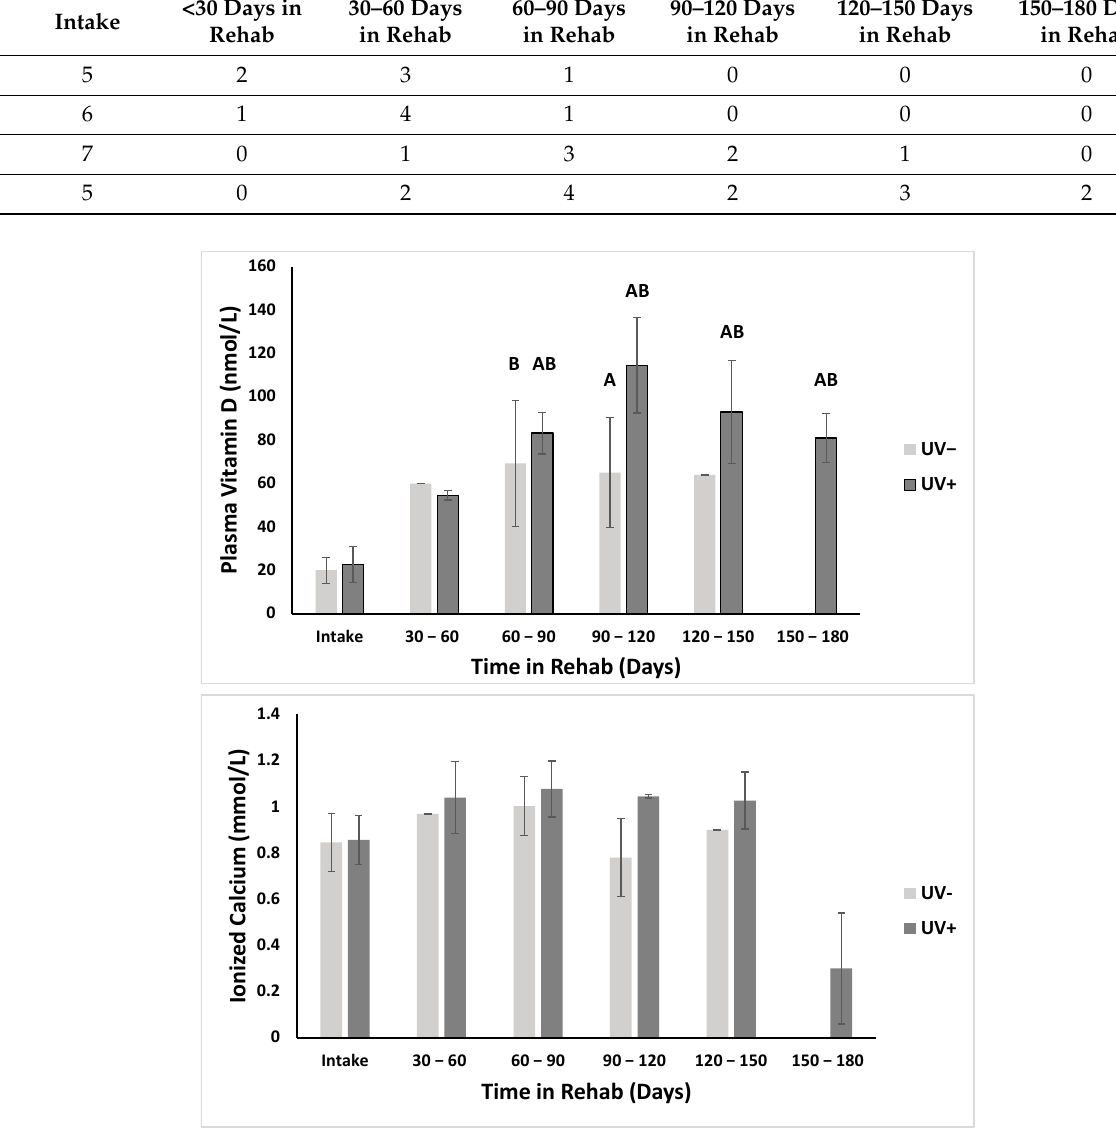
Figure 4. Change in plasma vitamin D ( top ) and ionized calcium ( bottom ) levels over time in turtles taken into rehabilitation with papilloma tumors (VT+). A = significant difference from UV − intake values. B = significant difference from UV+ intake values. p < 0.05.